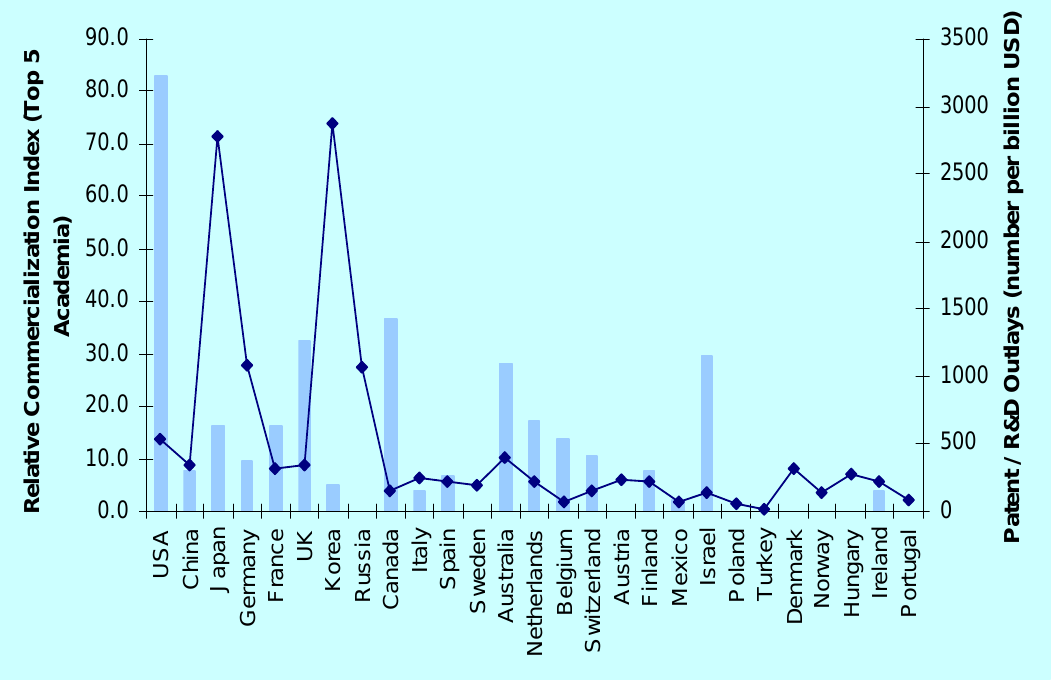
Figure 2. Biotechnology patent commercialisation. Composite index 2000–2004. Source: GDP from International Energy Agency; Patent number estimates from R&D Magazine; Biotechnology patent commercialization rankings from the Milken Institute. Bars: country relative publication index of its top five academia; line: patents / national R&D